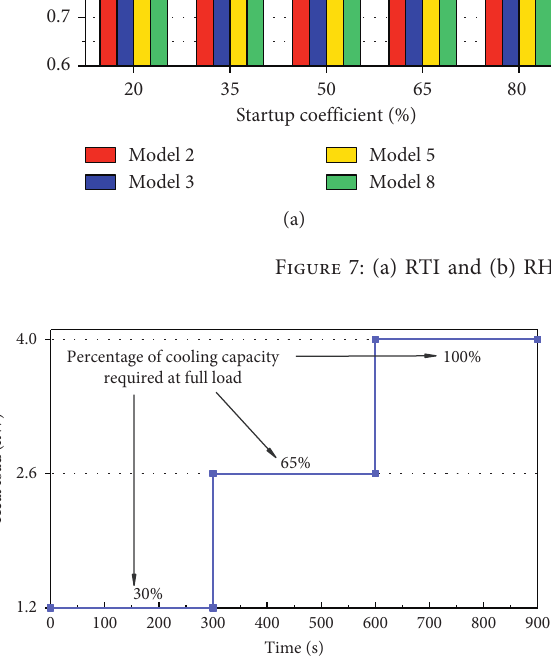
Figure 8: Schematic diagram of the transient attribute input file for changing the boot position.